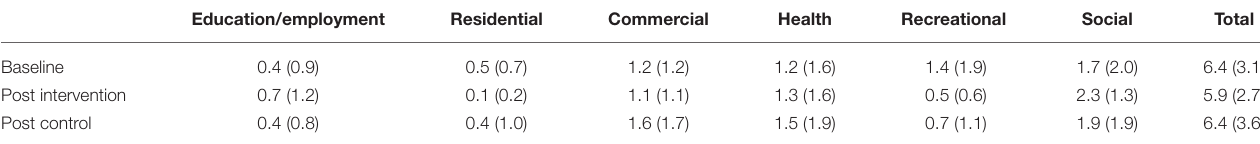
TABLE 5 | Self-reported episodes away from home M (SD).